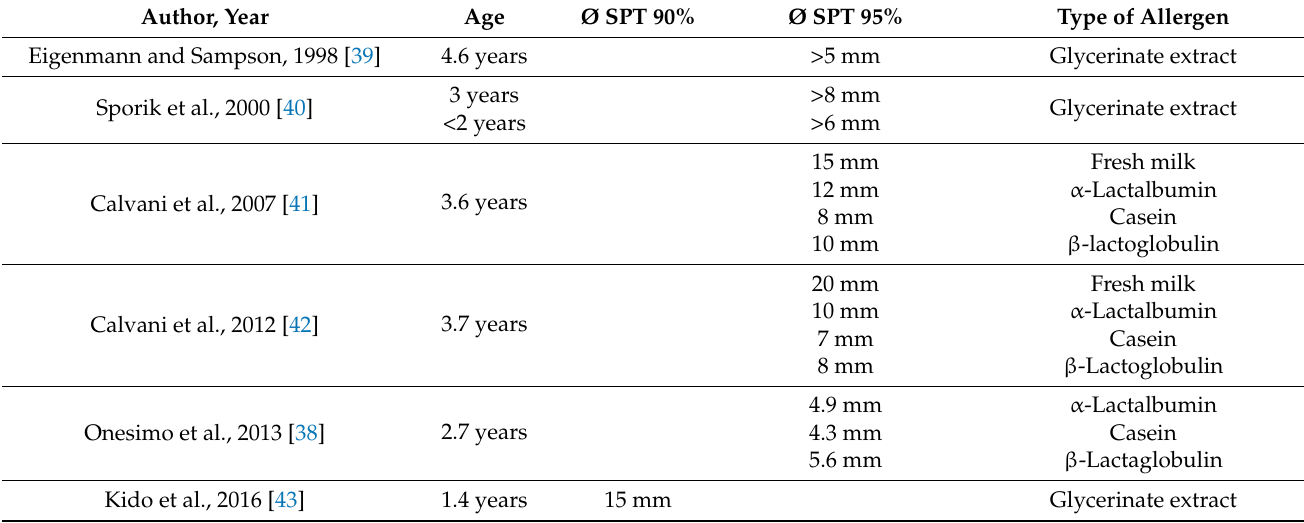
Table 3. Positive predictive value of 90% and 95% of SPT for a positive